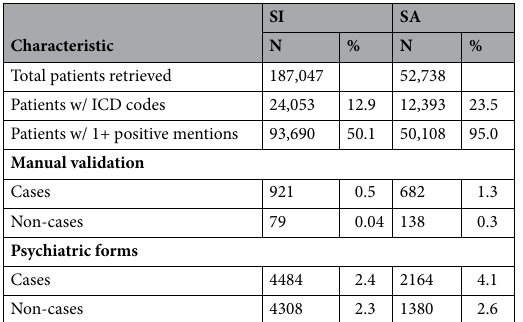
Table 1. Characteristics of patients retrieved by the NLP system. The extraction of cases and non-cases from psychiatric forms and chart review was restricted to the patients retrieved using NLP. The cases from psychiatric forms have at least one positive field while the non-cases have all the fields